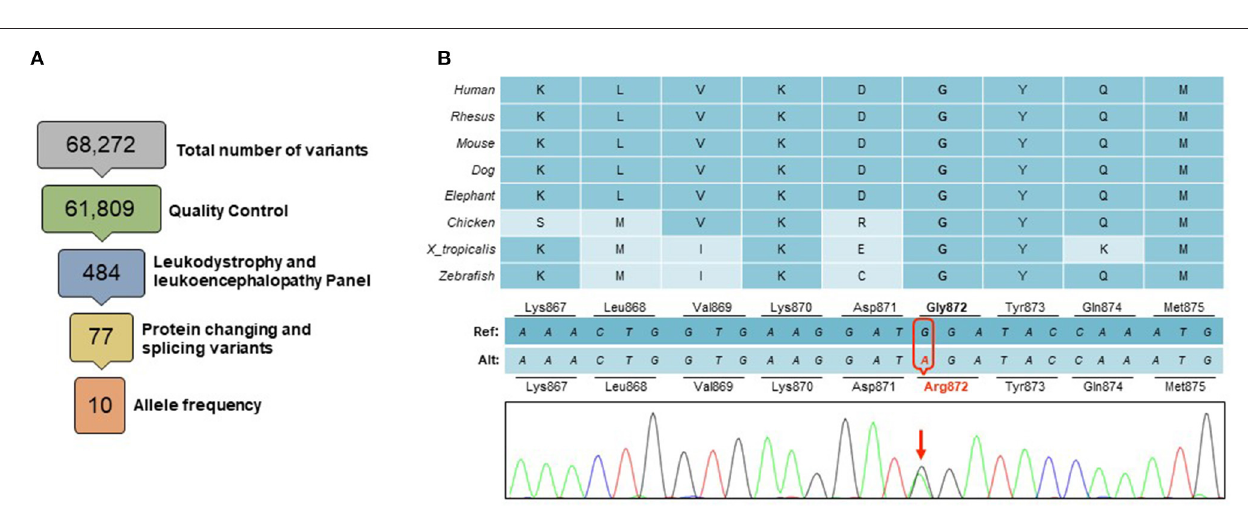
FIGURE 2 | Genetic findings. (A) A total of 68,272 variants were identified within the targeted exome. Variants of low quality were removed through quality control (GQ < 20, RD < 10, AF < 0.25). Among a panel of 165 genes known to be associated with leukodystrophies and leukoencephalopathies, a total of 484 variants were identified, of which 77 were protein changing or splicing variants. Only 10 of these had an allele frequency < 0.10 in gnomAD database, including a novel heterozygous missense variant in the CSF1R gene (B) This change in a highly conserved amino acid in the CSF1R tyrosine domain (p.Gly872Arg), was predicted to be deleterious by multiple in silico